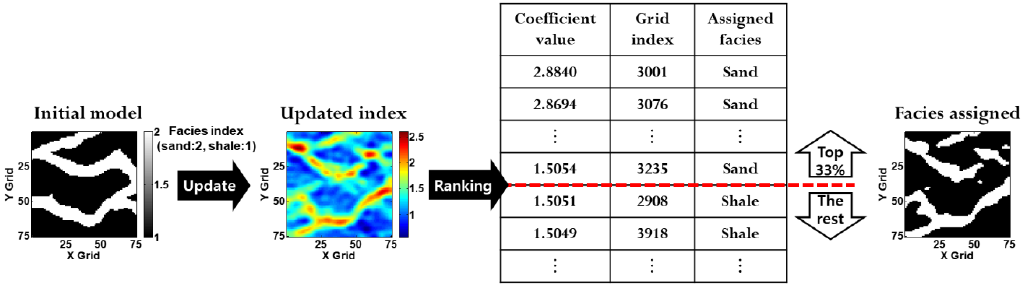
Figure 2. One realization example of the preservation of facies ratio (PFR) principle and application to an updated facies index field.